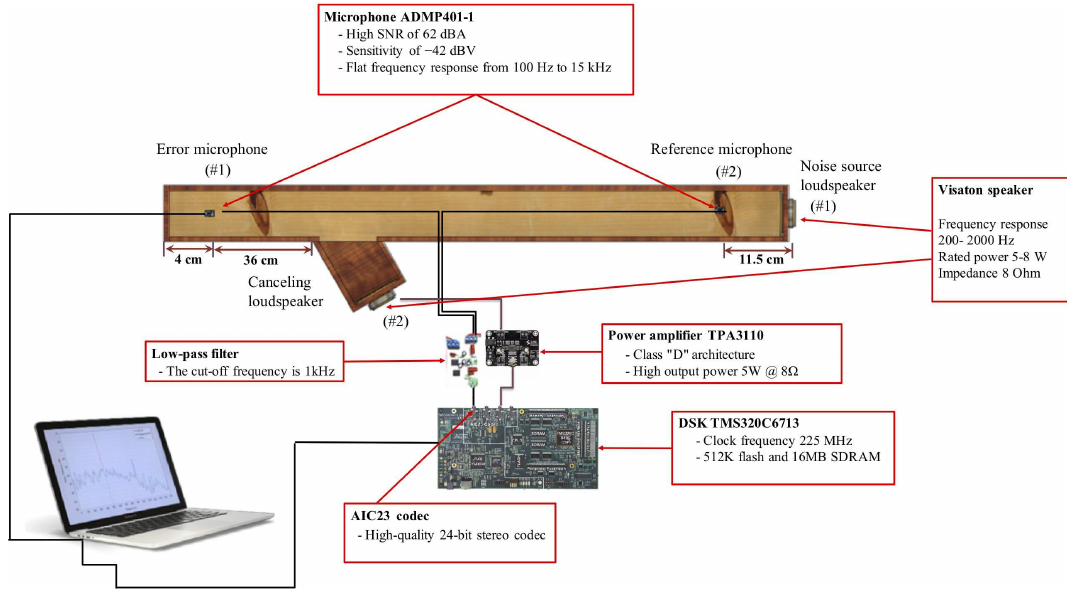
Figure 6. Experimental set-up for active noise reduction in a